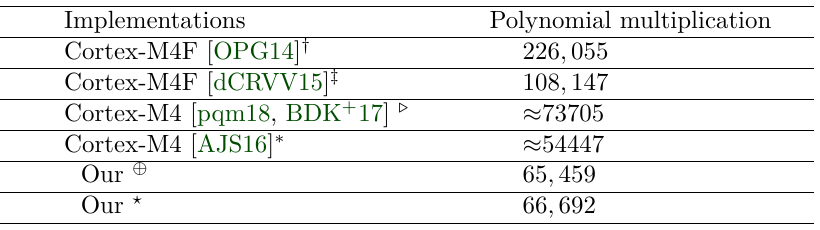
Table 4: Comparison of clock cycles for 256 × 256 polynomial multiplications with scaling when necessary. The cycle counts for NTT based multiplications are calculated as cycle count for 2*Forward NTT + Inverse